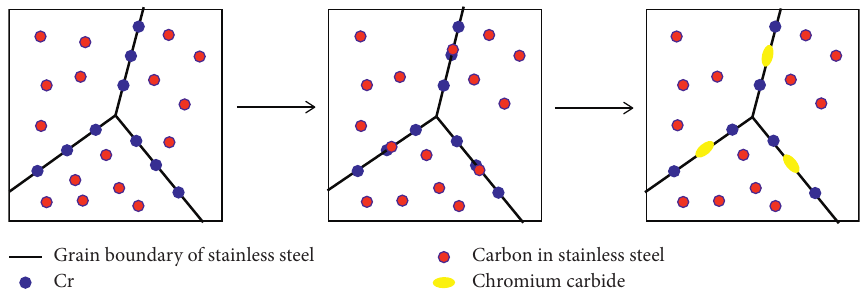
Figure 12: Schematic illustration of the formation of chromium-depleted region in stainless